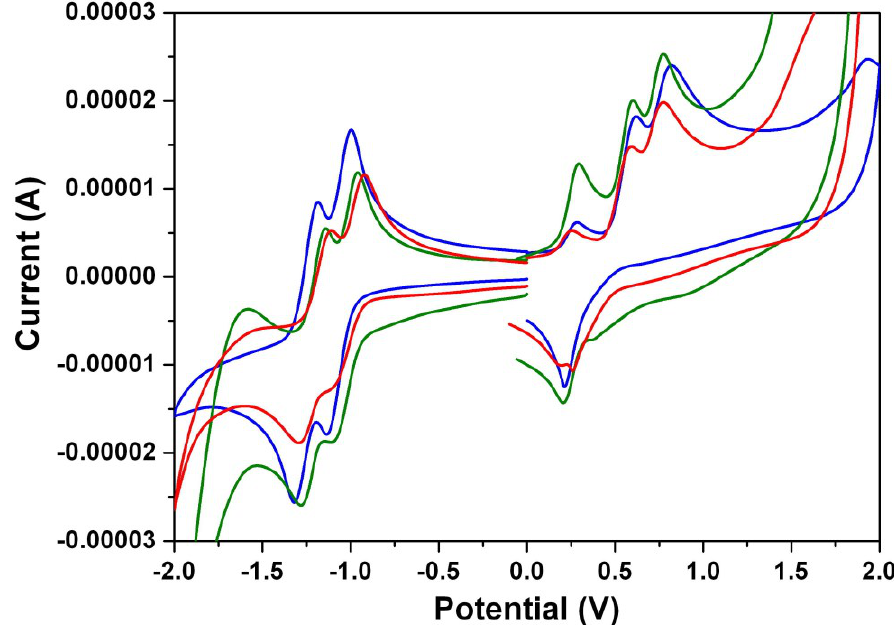
Figure 8. The cyclic voltammograms of 1a (blue line), 1b (green line), and 1c (red line) measured in dichloromethane solution with ferrocenium/ferrocene as an internal standard, at 200 mV/s.